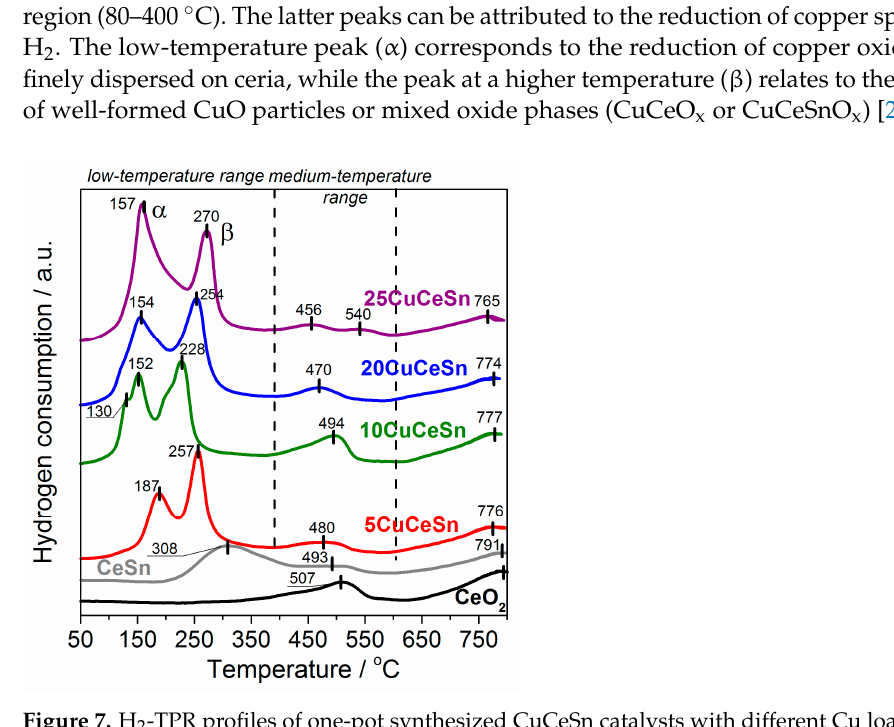
Figure 7. H 2 - TPR profiles of one-pot synthesized CuCeSn catalysts with different Cu